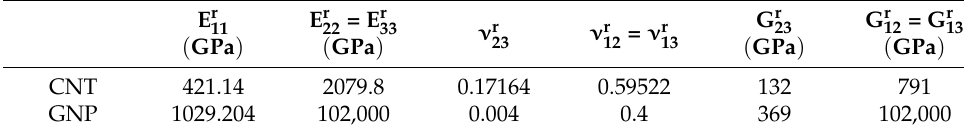
Table 2. Mechanical properties of CNT and GNP in terms of engineering constants.